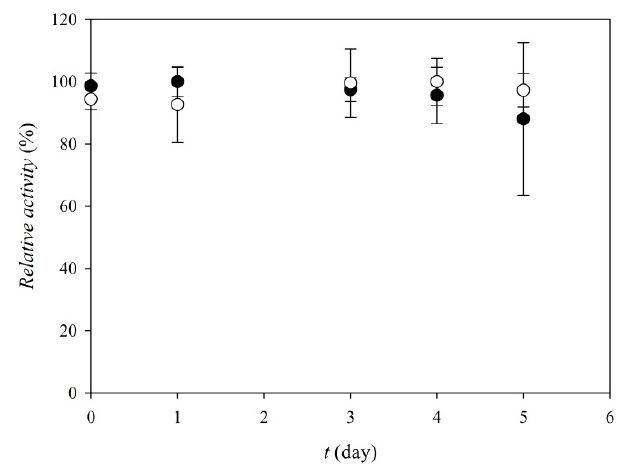
) T = 25 ◦ C, ( (cid:8) ) T = 4 ◦ C. (cid:35)